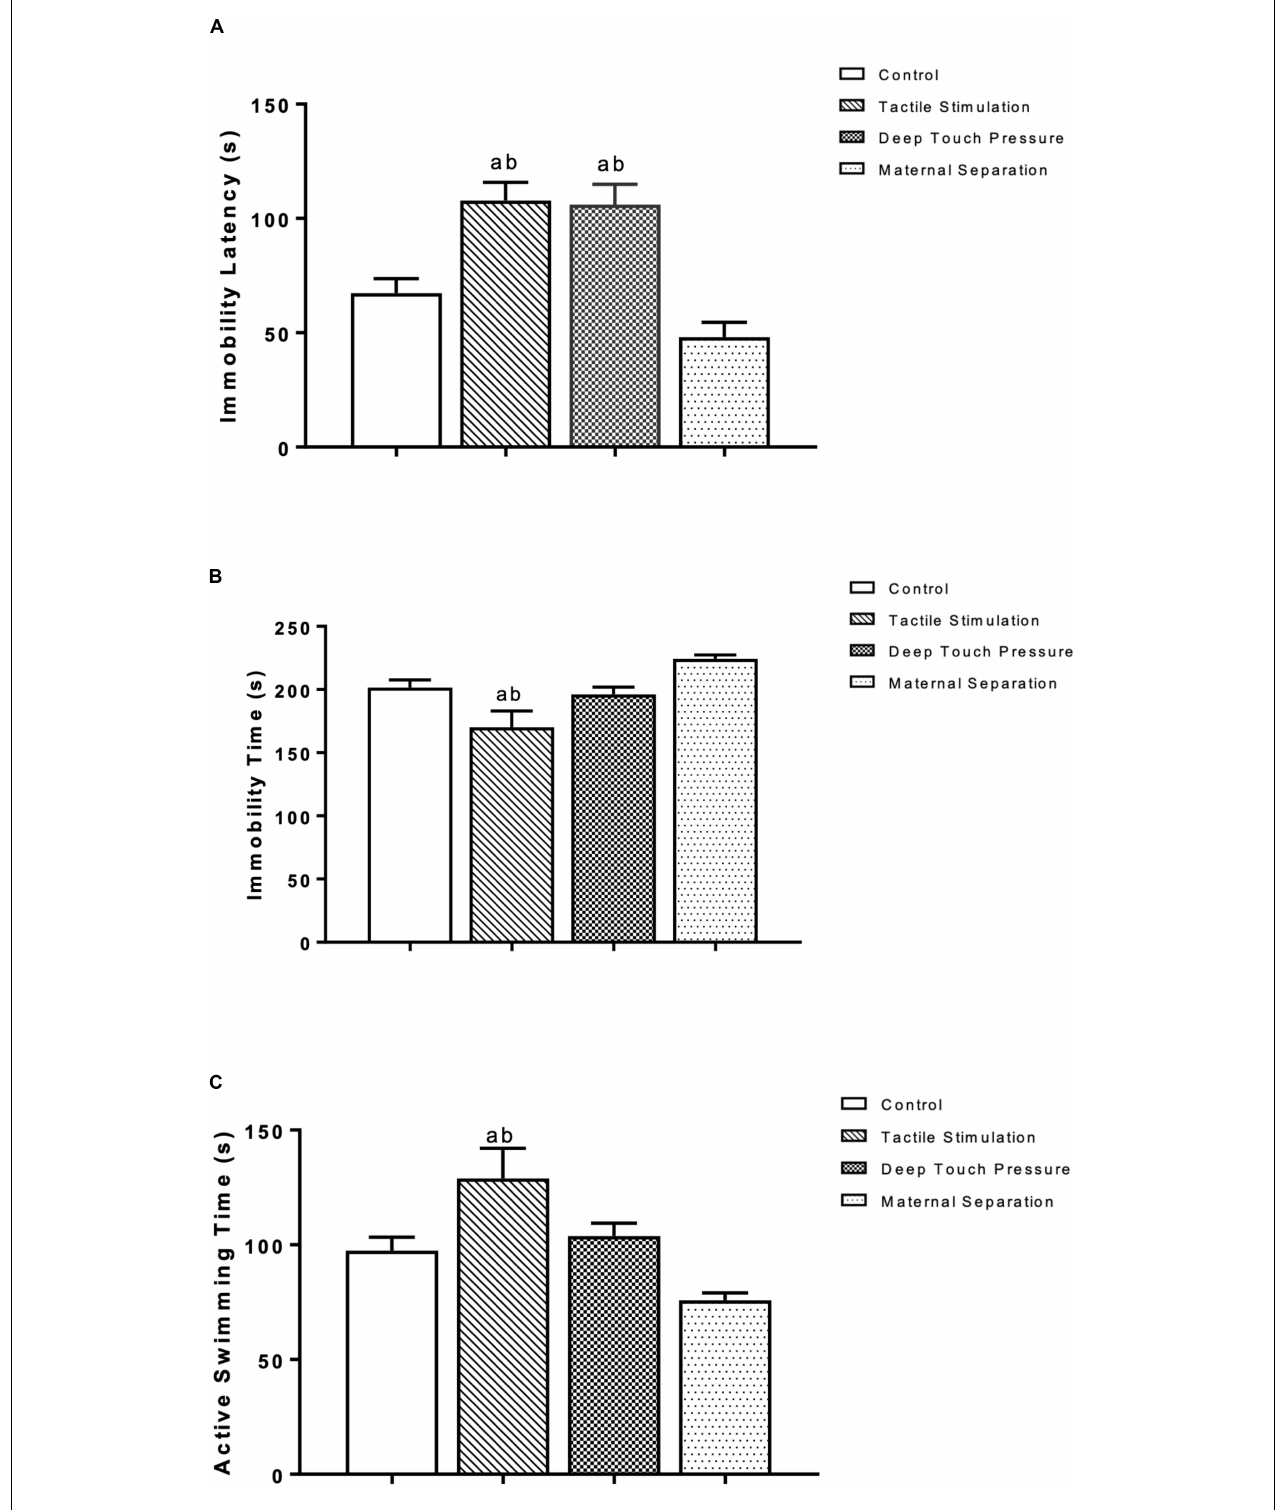
FIGURE 5 | Behavioral measures at the forced swimming test in WAG/Rij rats. The data are presented as mean ± SEM ( n = 10 per group). Immobility latency at (A) TS and DTP groups compared to the control group ( a p < 0.005) and immobility latency at TS and DTP groups compared to the MS group ( b p < 0.001); (B) Immobility duration, TS group compared to the control group ( a p < 0.05), TS group compared to MS group ( b p < 0.001); (C) Active swimming duration, TS group compared with control group ( a p < 0.05), TS group compared with MS group ( b p < 0.001) (one-way ANOVA).